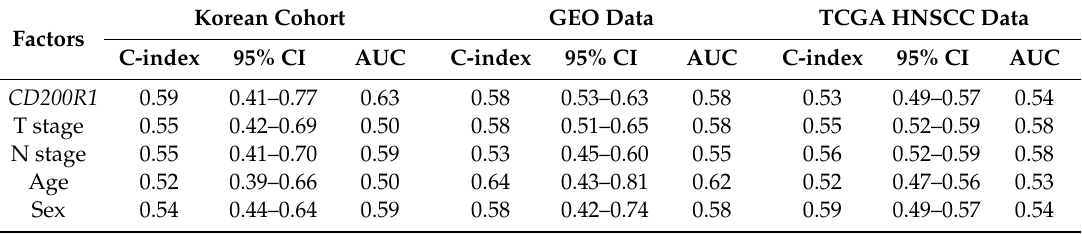
Table 3. C-index and AUC values for the prediction of five-year survival by CD200R1 and clinical factors in the Korean cohort and the GEO (GSE65858) and TCGA HNSCC